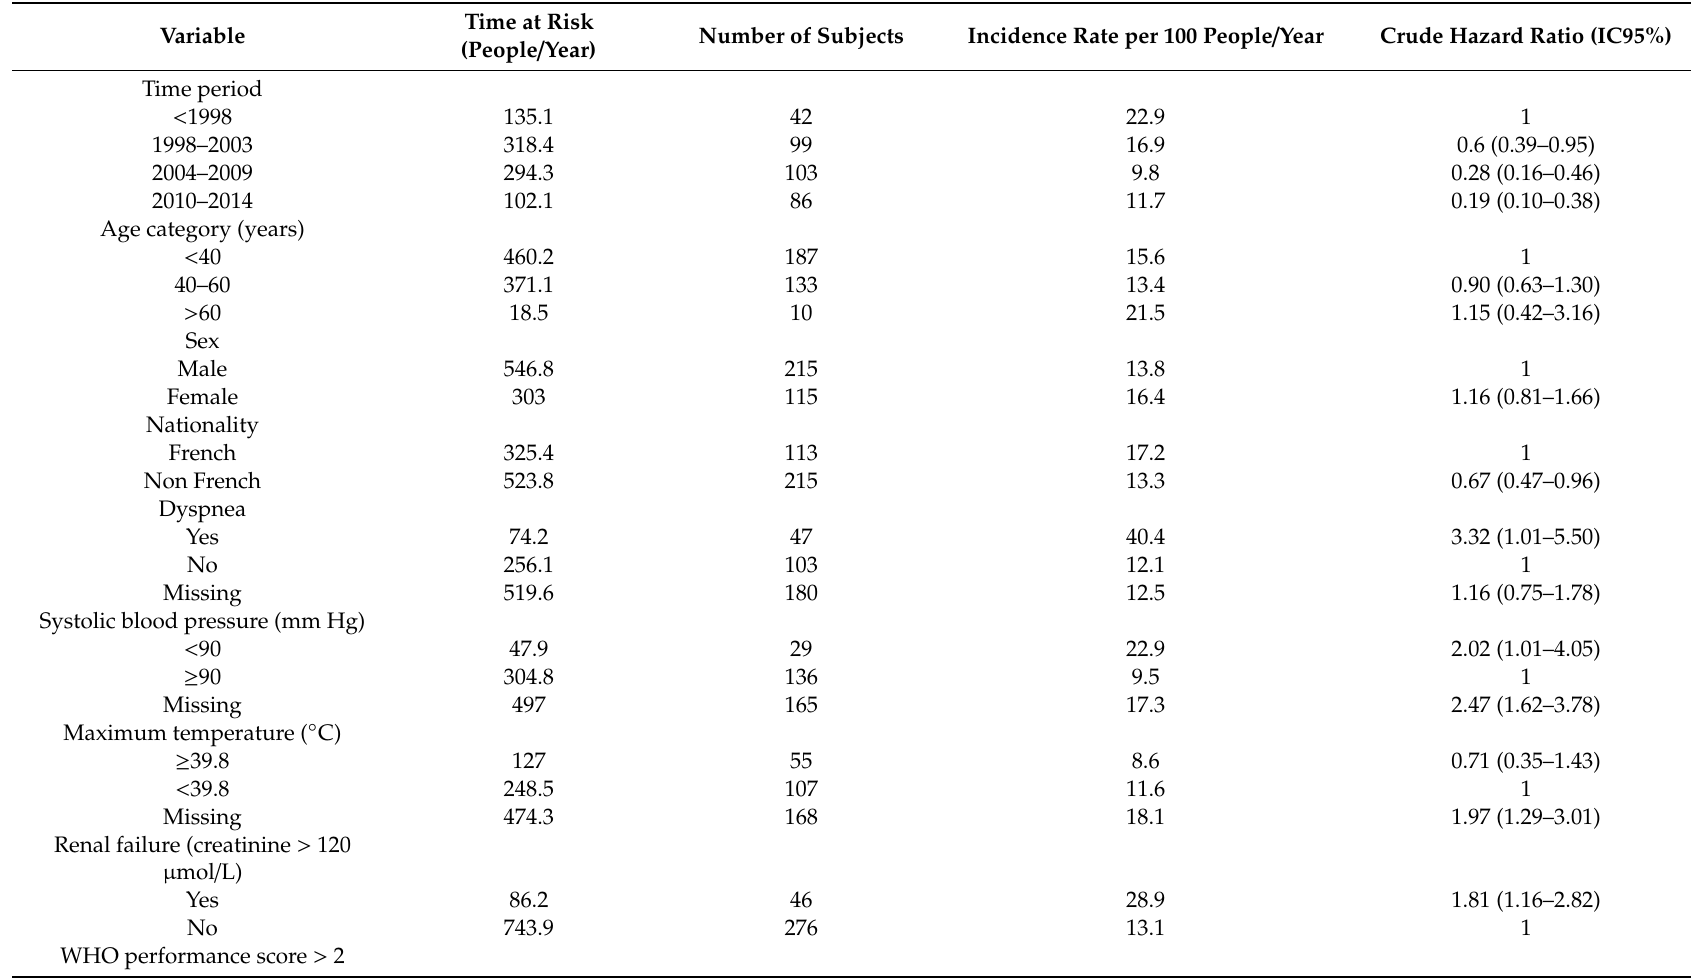
Table 1. Incidence rates of death and crude hazard ratios among Human Immunodeficiency Virus-infected patients with confirmed disseminated histoplasmosis.